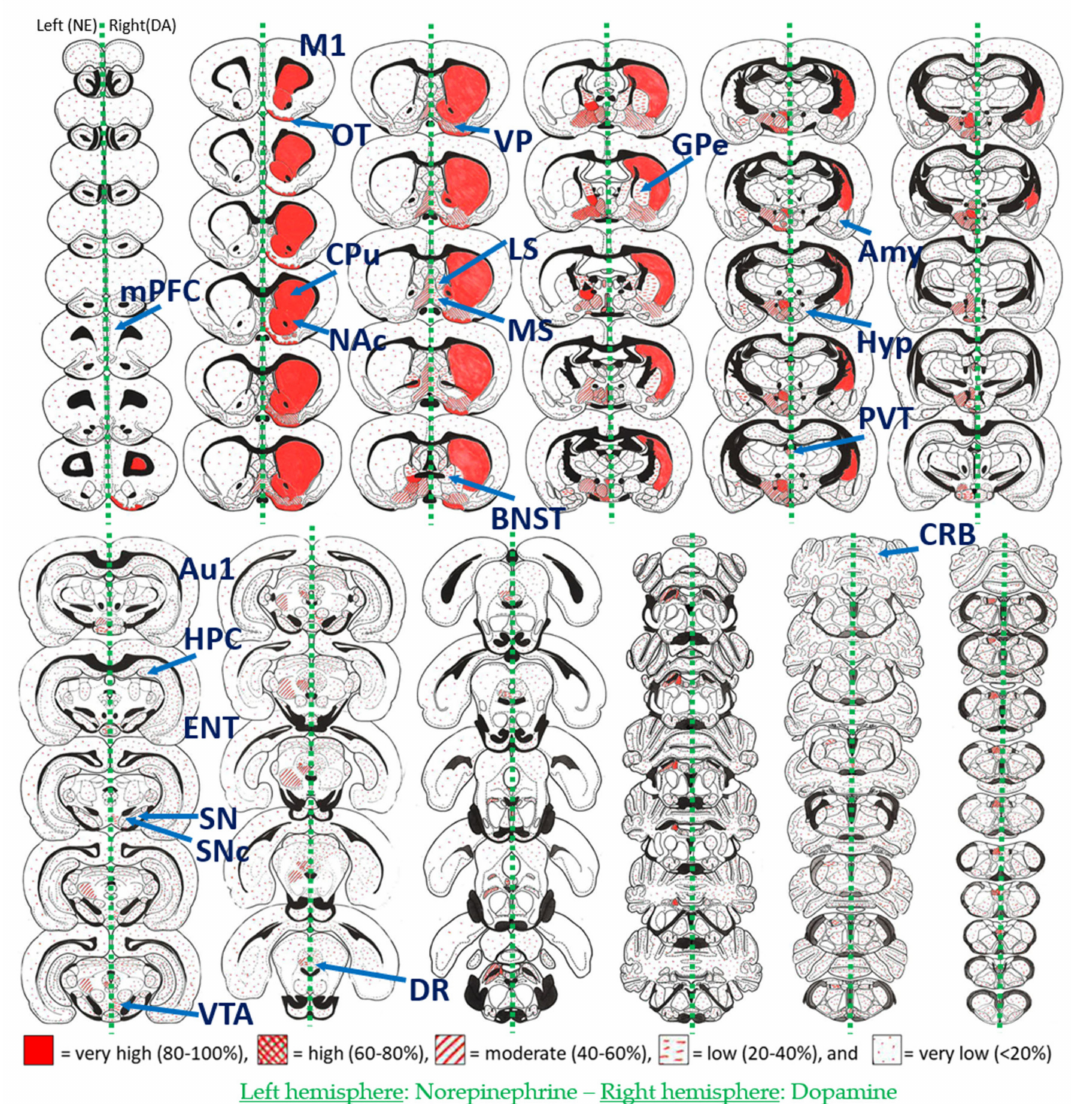
Figure2. Distributionofnorepinephrine(NE)(lefthemispheres)anddopamine(DA)(righthemispheres) neurotransmitter levels as measured by enzyme isotope biochemistry assays in micropunches of the rat brain. The red fill pattern indicates the percentage of NE and DA relative to the highest measured value. NE: very high = greater than 64.0; high = 48.1–64.0; moderate = 32.1–48.1; low = 16.0–32.1; very low = less than 16 ng / mg protein. DA: very high = greater than 83.6; high = 62.7–83.6; moderate = 41.8–62.7, low = 20.9–41.8; very low = less than 20.9 ng / mg protein. Of note, the distribution pattern of DA and NE in the dorsal striatum and NAc is dramatically distinct—with DA content being very high (80–100%), while NE content is very low (less than 20%). Au1: primary auditory cortex; BNST: Bed nucleus of the stria terminalis; CPu: caudate-putamen ( = dorsal striatum); CRB: cerebellum; DR: dorsal raphe; ENT: entorhinal cortex; GPe: globus pallidus externus; HPC: hippocampal formation; Hyp: Hypothalamus; LS: lateral septum; M1: primary motor cortex; mPFC: medial prefrontal cortex; MS: medial septum; NAc: Nucleus accumbens; OT: olfactory tubercle; PVT: paraventricular nucleus of the thalamus; SN: substantia nigra; SNc: SN compacta; TeA: temporal association cortex; VP: ventral pallidum; VTA: ventral tegmental area. For detailed brain region annotations see the original image source [130]. This Figure was modified with permission from Björklund & Hökfelt (1984), Handbook of Chemical Neuroanatomy, Vol. 2–Part 1. © Elsevier Science Publishers B.V. (1984), Amsterdam, Netherlands